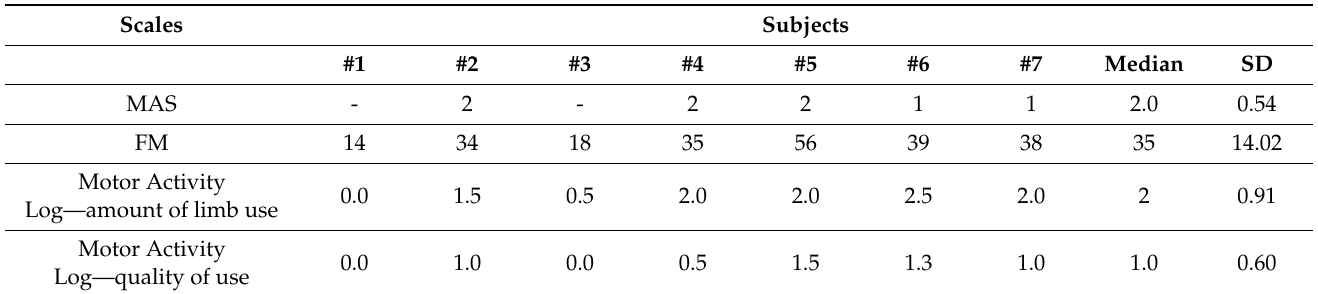
Table 3. Results: the median and standard deviation of the clinical scales applied to individuals ( n = 7) with stroke.